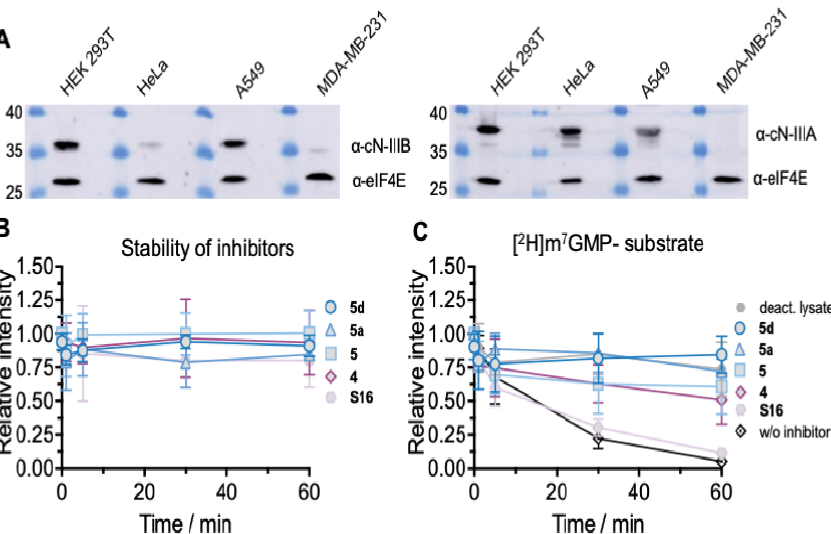
Figure 9. ( A ) Protein expression profile of endogenous level of cN ‐ IIIB and cN ‐ IIIA in different cell lines. As a reference, the expression of eIF4E protein was shown. ( B ) Stability of indicated compounds in HEK 293T cell lysate determined by LC–MS/MS. ( C ) m 7 GMP decay in HEK 293T cell extract in the presence of compounds with different inhibitory potencies. Data points represent mean values from triplicate experiments ± S.D.